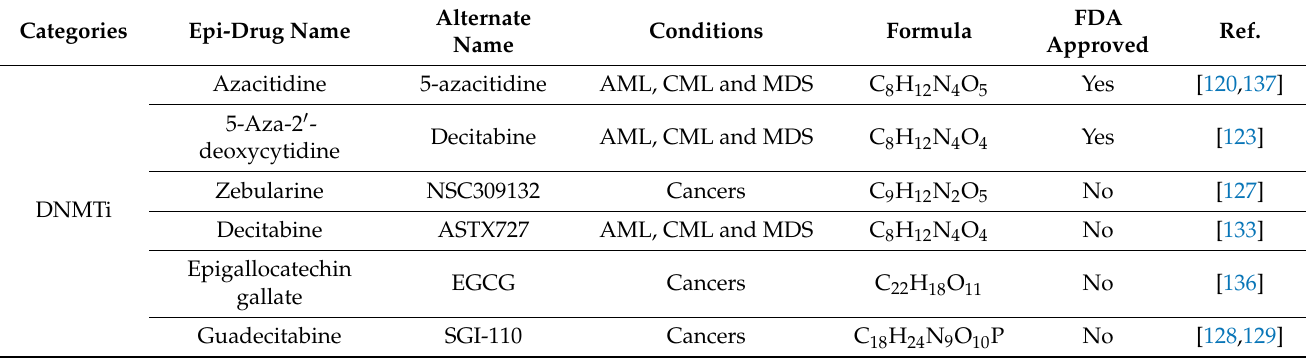
Table 1. Epigenetic drugs to inhibit DNMT, which contains information about the name of drug/alternate name, formula, and applicable in treatment of various diseases, and whether they are approved by the FDA or